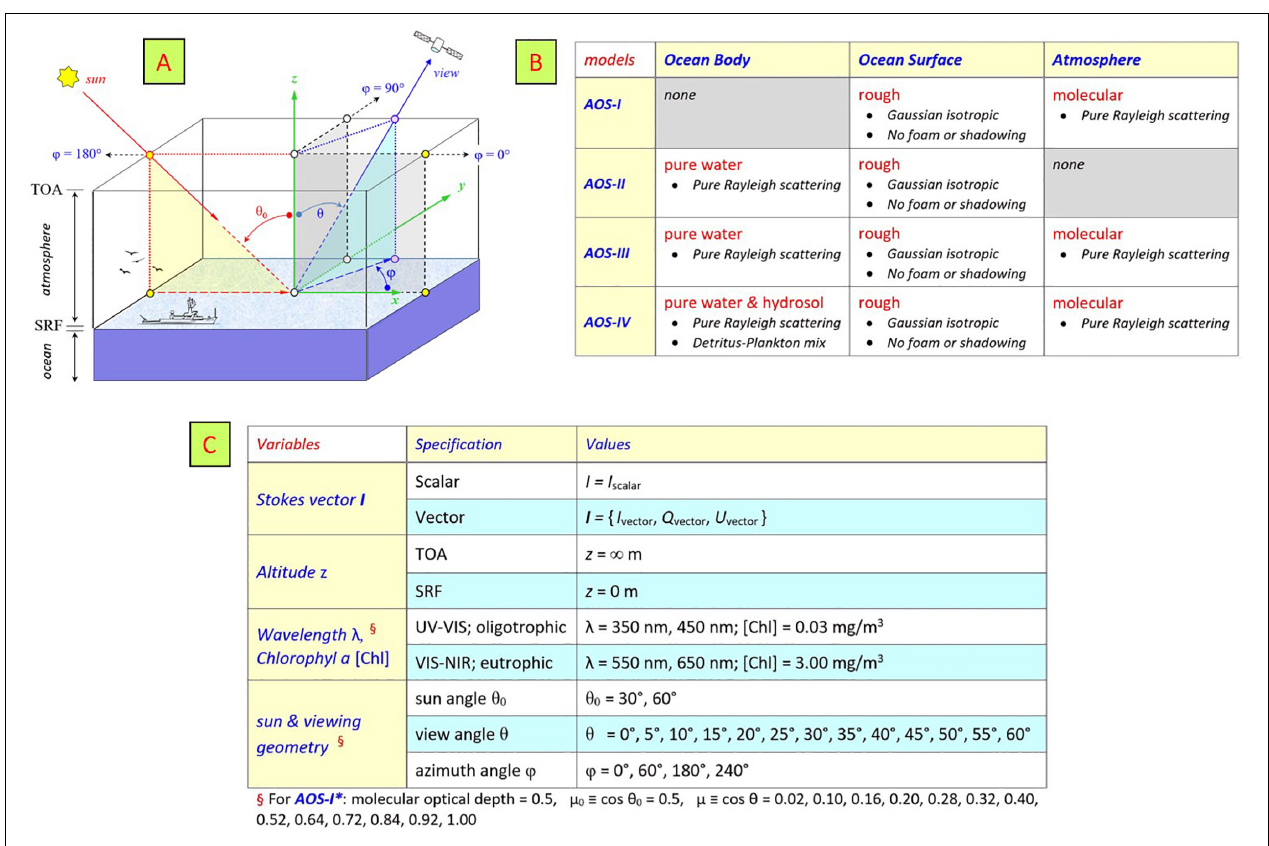
FIGURE 12 | (A) Schematic illustration of Atmosphere-Ocean System (AOS) model and scattering geometries used for RT benchmark computations. (B) Specification of AOS models shown in sub-panel (A) . (C) Specification of variables used for each AOS model computation.